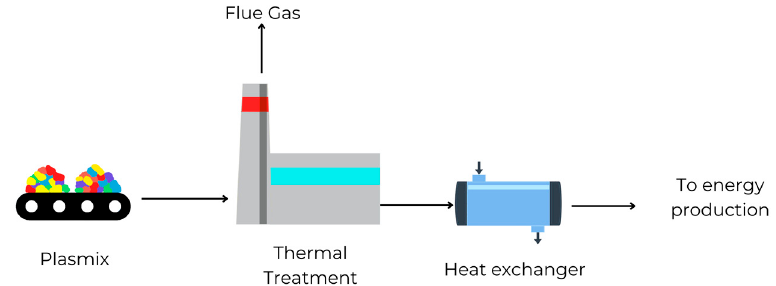
Figure 2. Schematic of the incineration process.